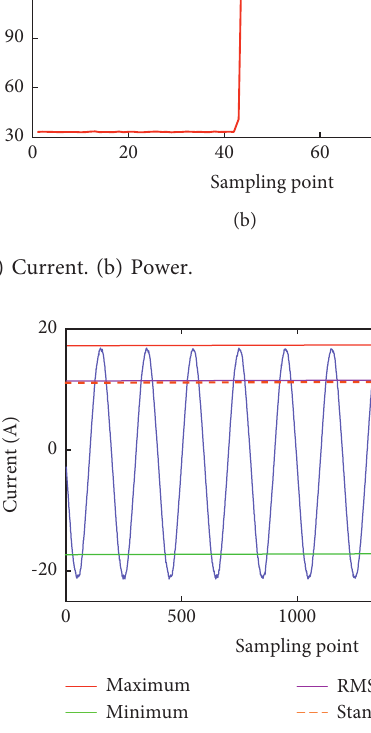
Figure 3: Current characteristics of the